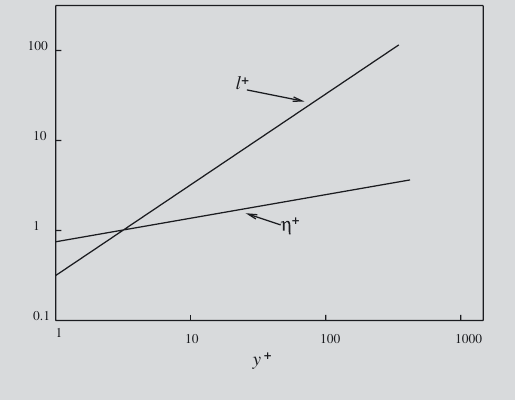
Figure 4: A schematic plot showing the growing spectrum of length scales as the distance from the wall increases in Newtonian channel